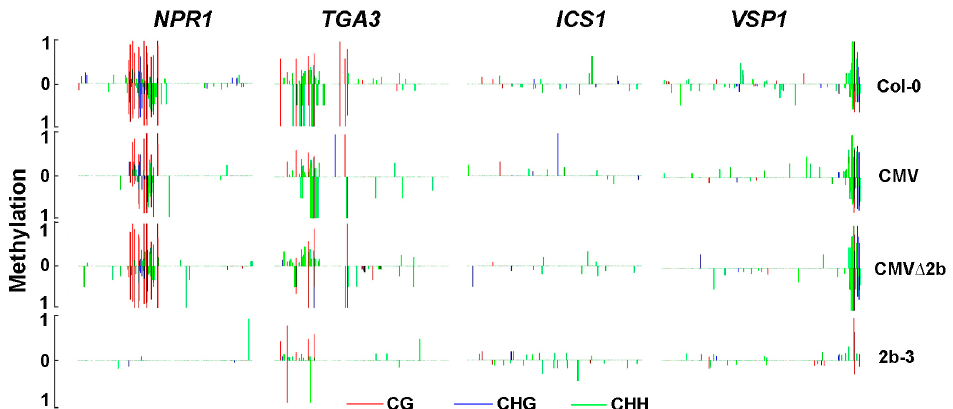
Figure 6. The methylation level in the promoters of genes involved in SA pathway. Vertical lines show the methylation level of each cytosine in Col-0, CMV-, CMV ∆ 2b- and 2b-3 plants. Viruses 2018 , 10 , x FOR PEER REVIEW